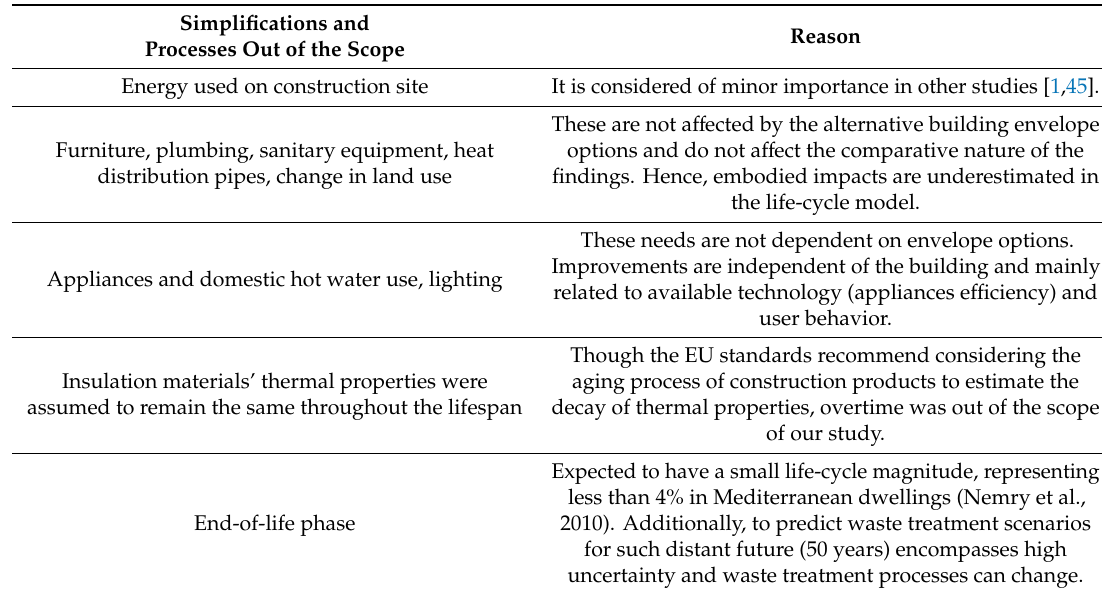
Table 1. Life-cycle model simplifications.